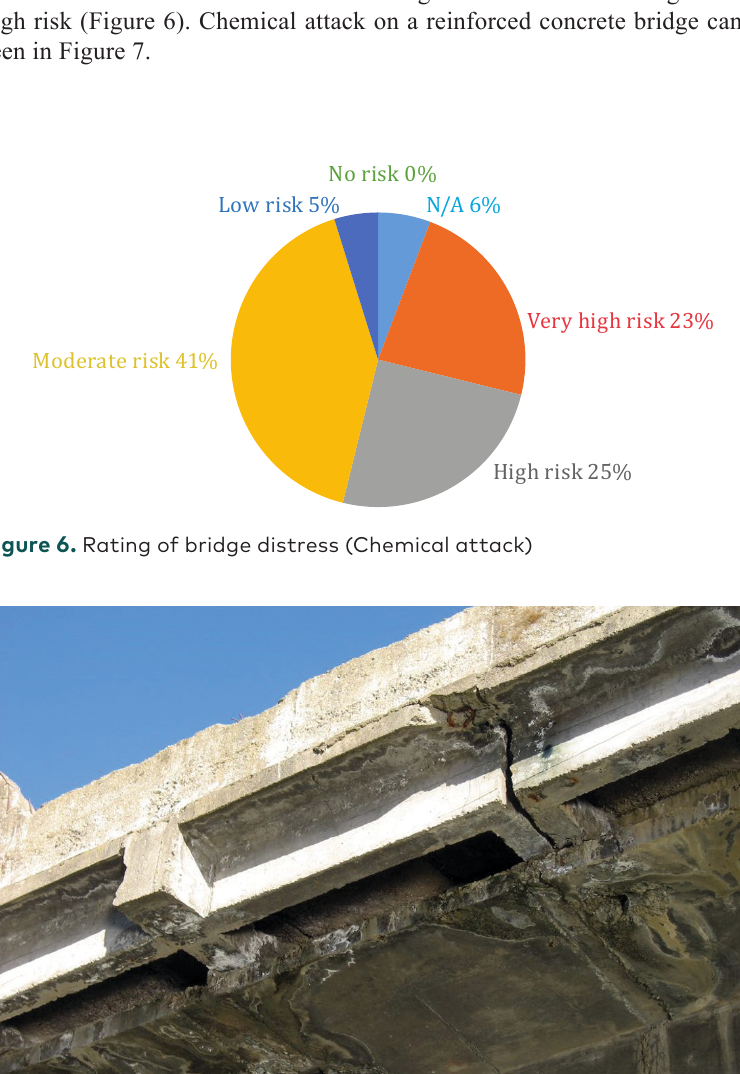
Figure 7. Chemical attack on a reinforced concrete bridge